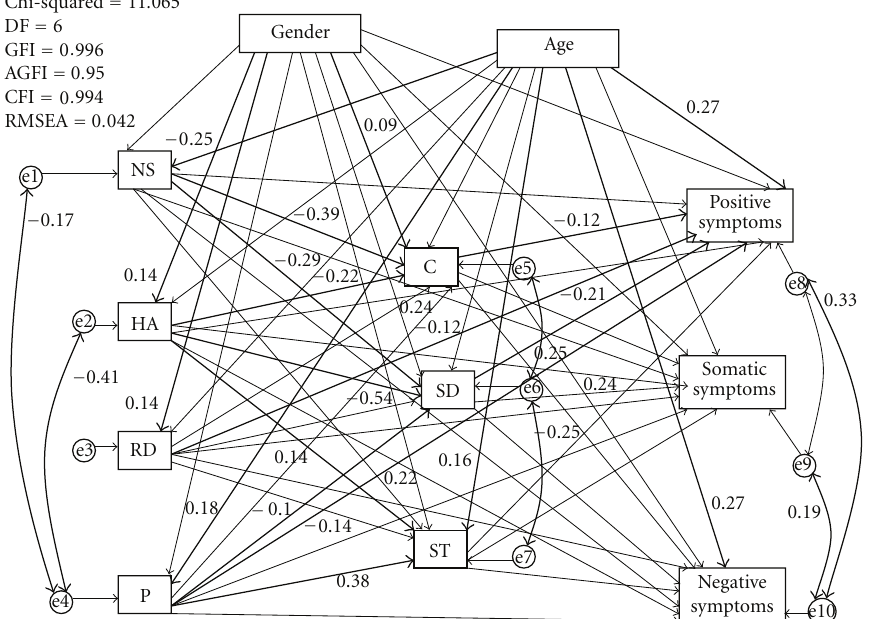
Figure 2: The path model with estimates. NA: negative a ff ectivity; NS: novelty seeking; HA: harm avoidance; RD: reward dependence; P: persistence; SD: self-directedness; C: cooperativeness; ST: self-transcendence. All standardized parameter estimates in bold are significant ( P < 0 . 05). Estimates without significance are in fine